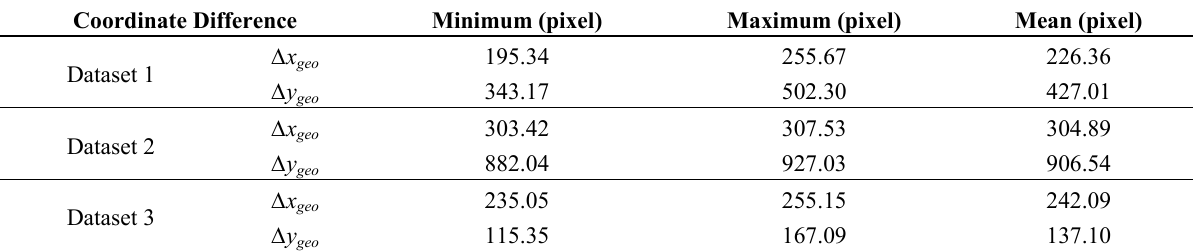
Table 3. Statistics of coordinate differences between corresponding